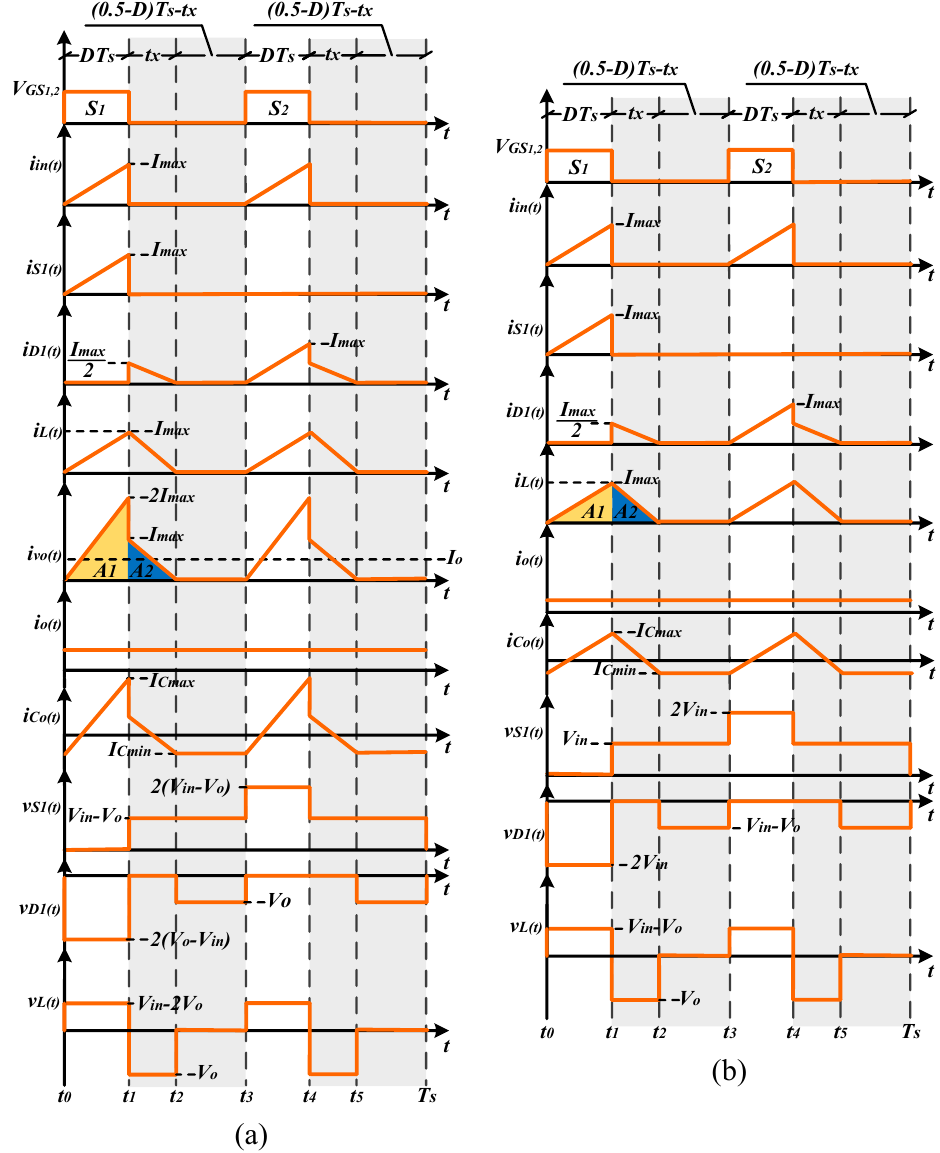
Figure 3. 3SSC-A-based step-down converters waveforms in DCM: ( a ) 3SSC-A-based buck; ( b ) 3SSC- A-based